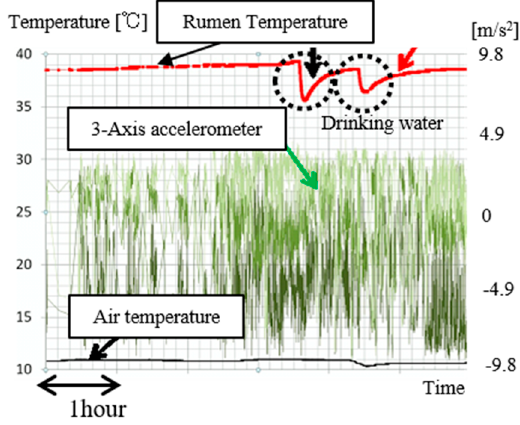
Figure 7. Temperature data and three-axis acceleration data for x-axis, y-axis and z-axis when the cow was drinking.